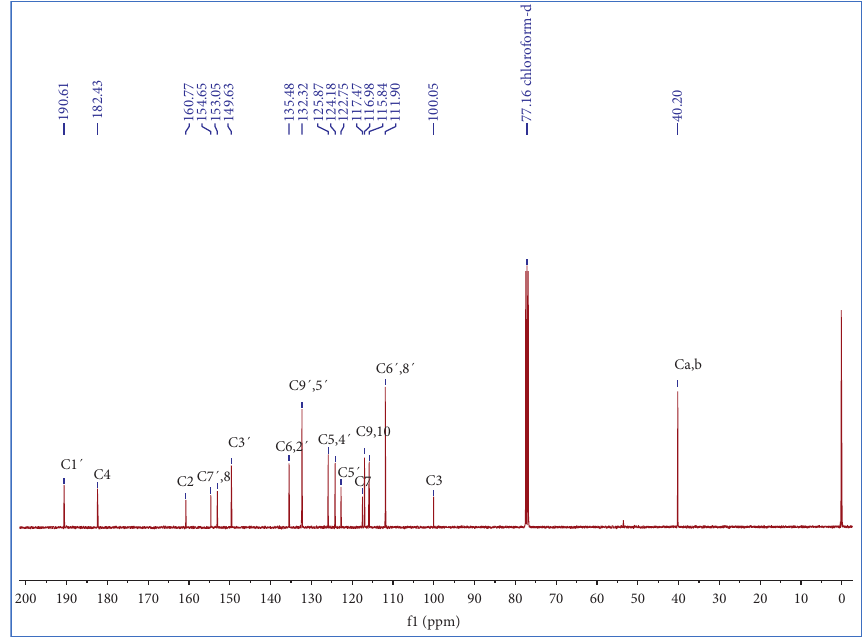
Figure 3: 13 C NMR spectrum (100MHz, CDCl